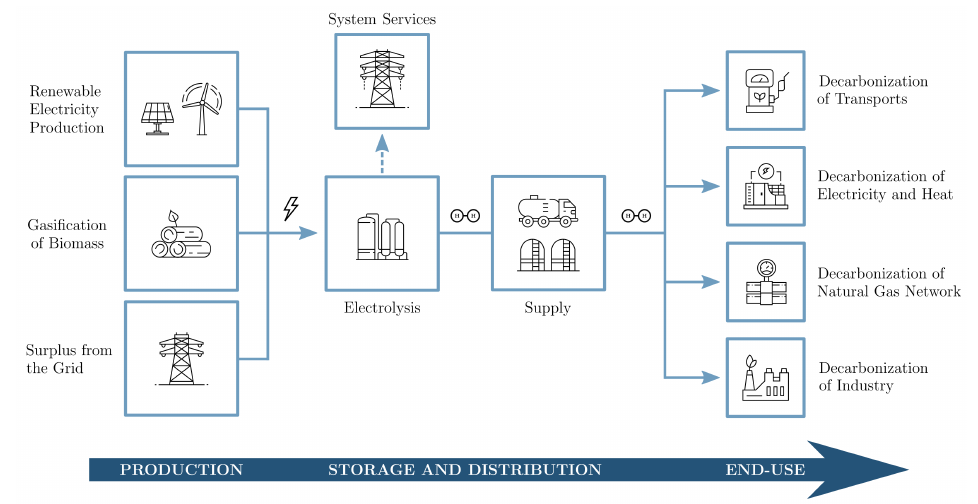
Figure 1. General flowchart of hydrogen’s value chain. Adapted from